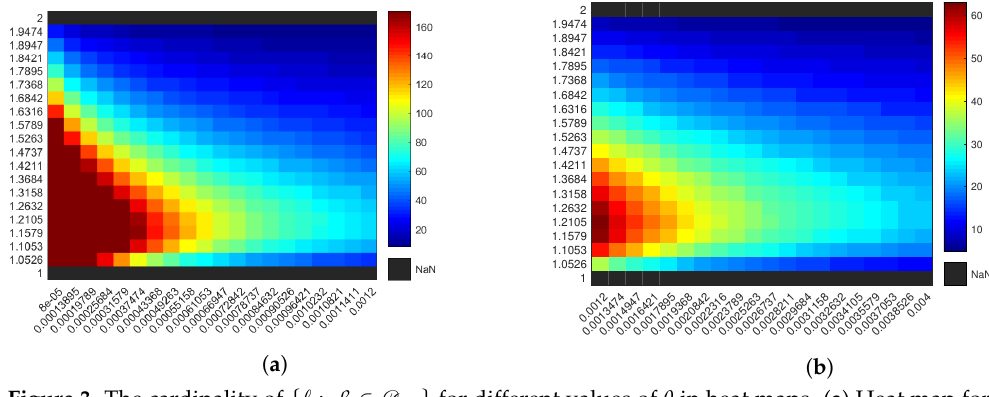
Figure 3. The cardinality of { (cid:96) : β ∈ D (cid:96) , θ } for different values of θ in heat maps. ( a ) Heat map for { (cid:96) : β ∈ D (cid:96) } with 0 ≤ θ ≤ 0.0012. ( b ) Heat map for { (cid:96) : β ∈ D (cid:96) , θ